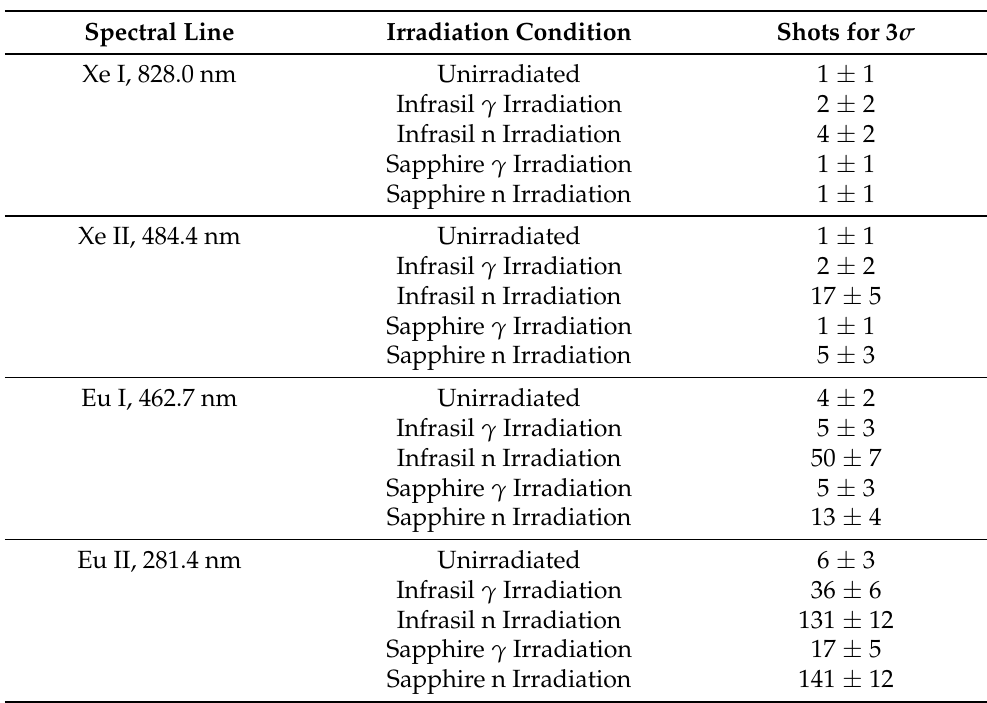
Table 1. The minimum number of laser shots for a 3 σ detection level for the examined materials, dependent on the irradiation method and received